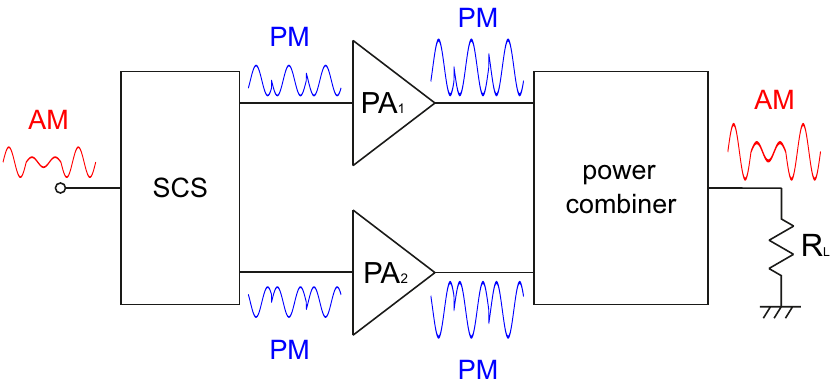
Figure 10. Outphasing power amplifier scheme. SCS: Signal Component Separator; AM: Amplitude-Modulated; PM: